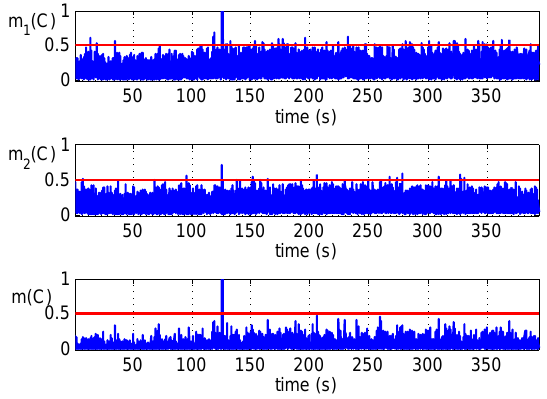
Figure 7. Detections’ fusion of the Scenario 1 dataset.